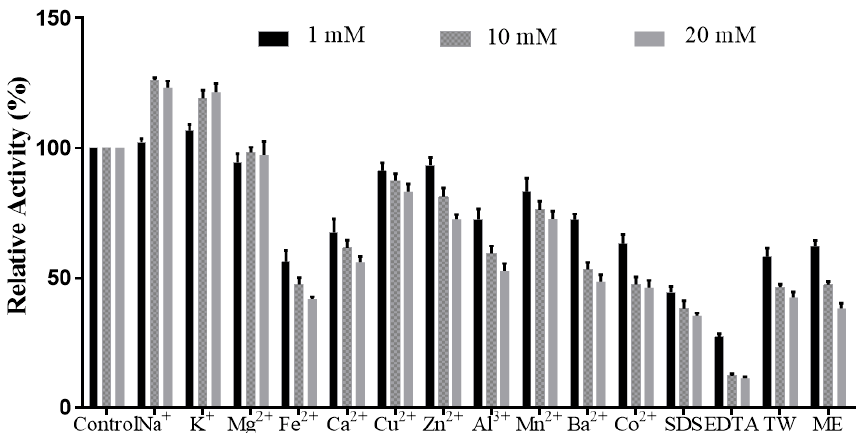
Figure 6. Effects of metal ions, SDS, TW, ME, and EDTA on L01 activity ( n = 3). TW: Tween 80, ME: mercaptoethanol.